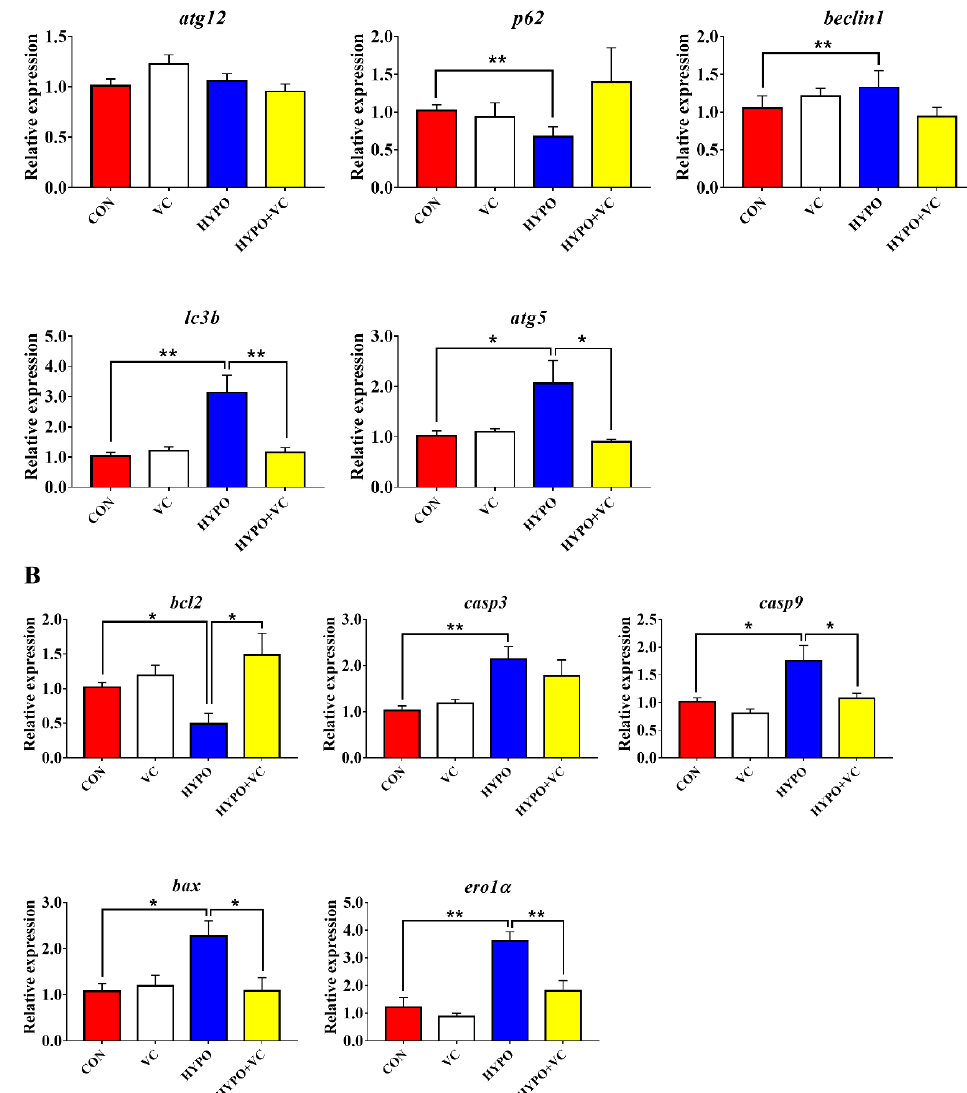
Figure 7. Changes of the expression levels of autophagy ( A ) and apoptosis ( B )-related genes in the liver of gibel carp in the normal group and hypoxia group after 56 days of feeding with VC. The * or ** at the top of the bar chart indicates significant difference between treatments; * indicates a significant difference ( p < 0.05), and ** indicates an extremely significant difference ( p < 0.01). All of the data are presented as the mean ± standard error (n = 6).